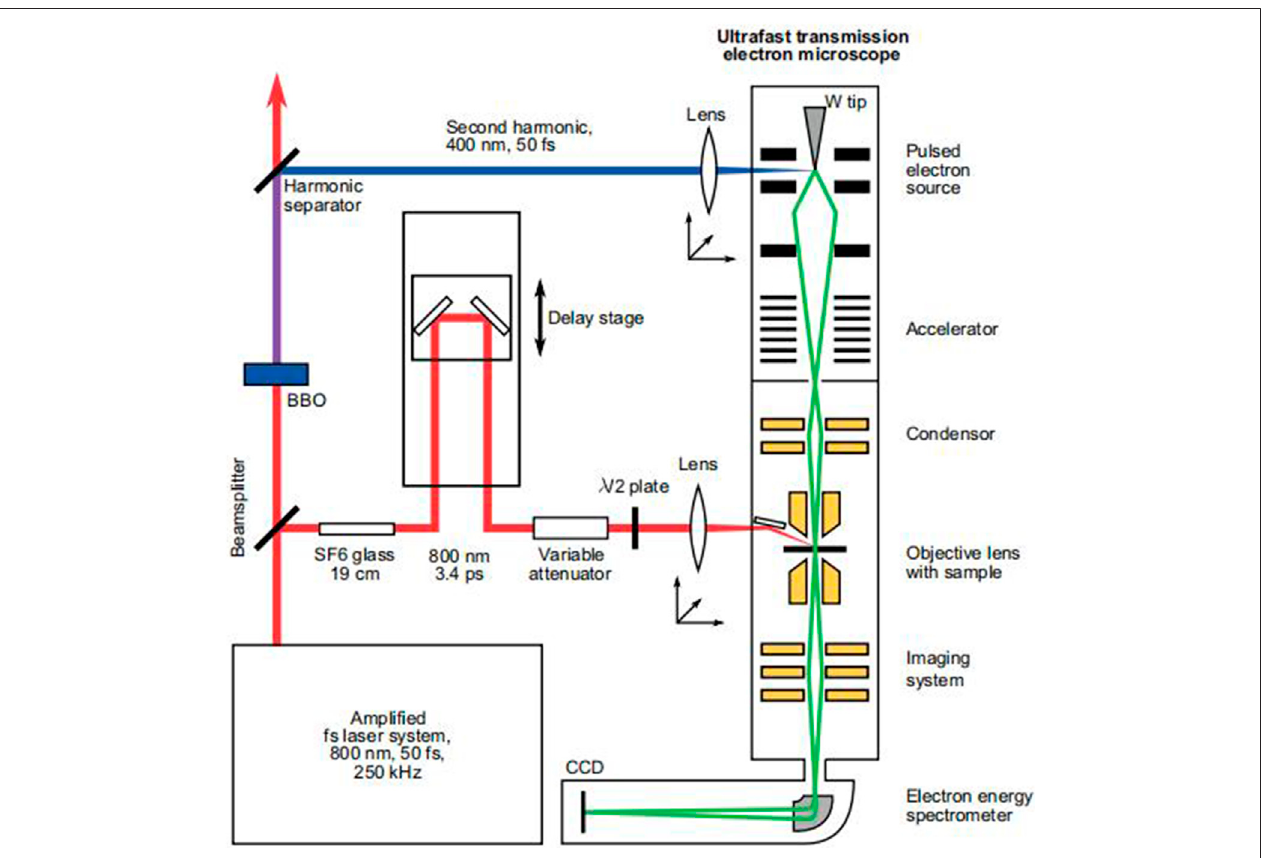
FIGURE 1 | Diagram of the principle of TEM (Feist et al.,